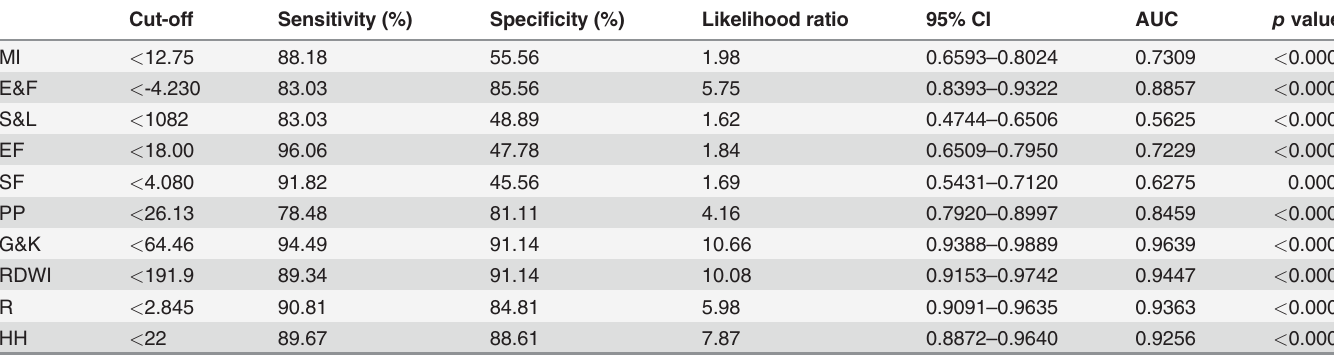
Table 5. The proposed cut-off values of different discrimination index in differentiation of α -thalassemia minor from IDA.